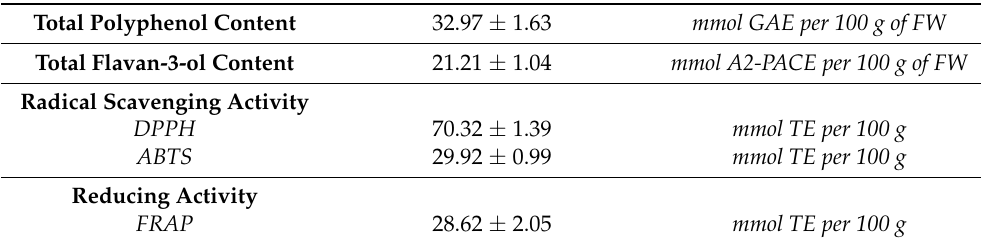
Table 1. Total Polyphenol Content, Total Flavan-3-ol Content, Radical Scavenging Activity (ABTS and DPPH) and Reducing Activity (FRAP) of F1-BEO. DPPH: 2,2-diphenyl-1-picrylhydrazyl; ABTS: 2,2 (cid:48) -azino-bis(3-ethylbenzothiazoline-6-sulphonic acid; FRAP: Ferric Reducing Antioxidant Power;